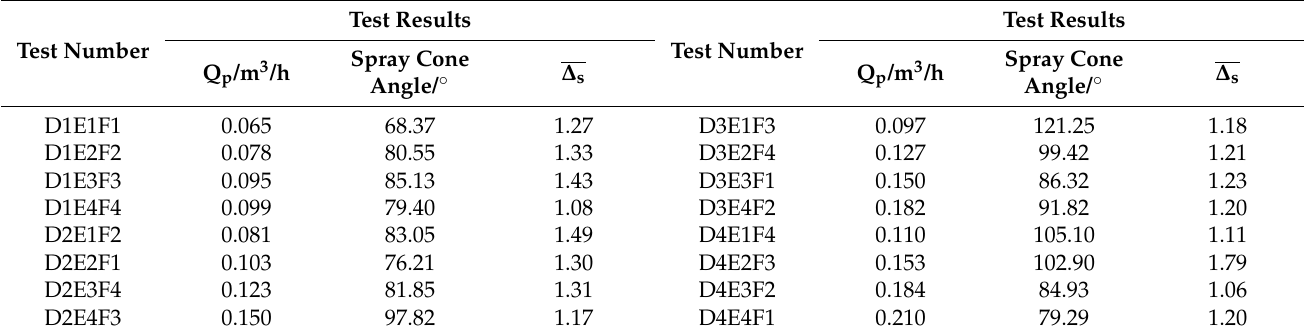
Table 6. Results of the performance tests of spraying